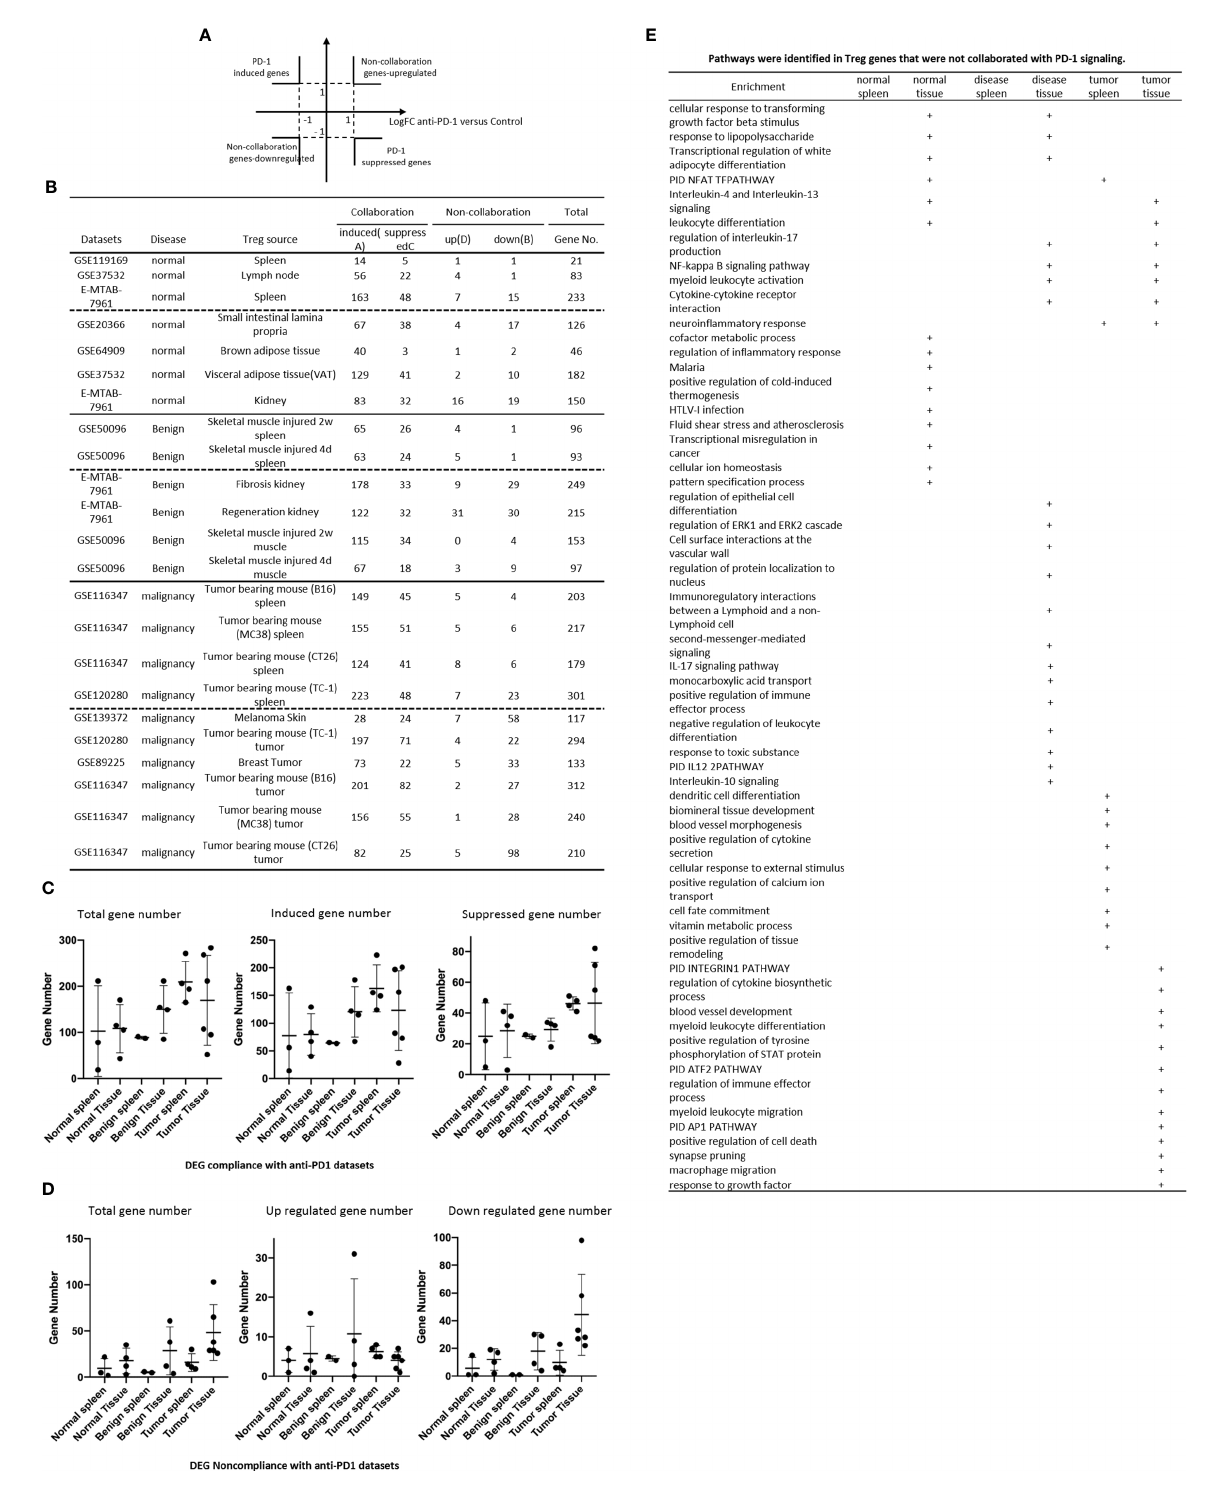
FIGURE 8 | (A, B) All the upregulated genes and downregulated genes in tissue Treg groups were compared to anti-programmed death-1 (PD-1) antibody-treated Treg (PD-1 signaling suppressed) versus PD-1 signaling non-suppressed CONTROL CD4+ T cell dataset (GSE114300) to determine how many Treg genes were dependent on PD-1 signaling. (C) Treg DEG collaboration with PD-1 induced genes and PD-1 suppressed genes in anti-PD-1 datasets. (D) Treg DEG non-collaboration with PD-1 induced genes and PD-1 suppressed genes in anti-PD-1 datasets. (E) pathways identi fi ed in Treg genes and not collaborated with PD-1